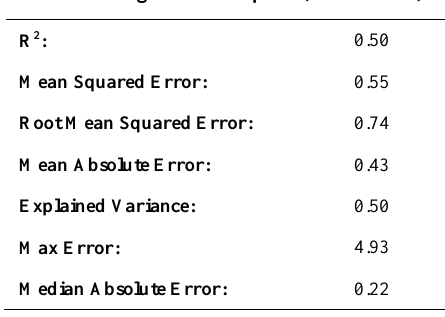
Table 2. Regression outputs